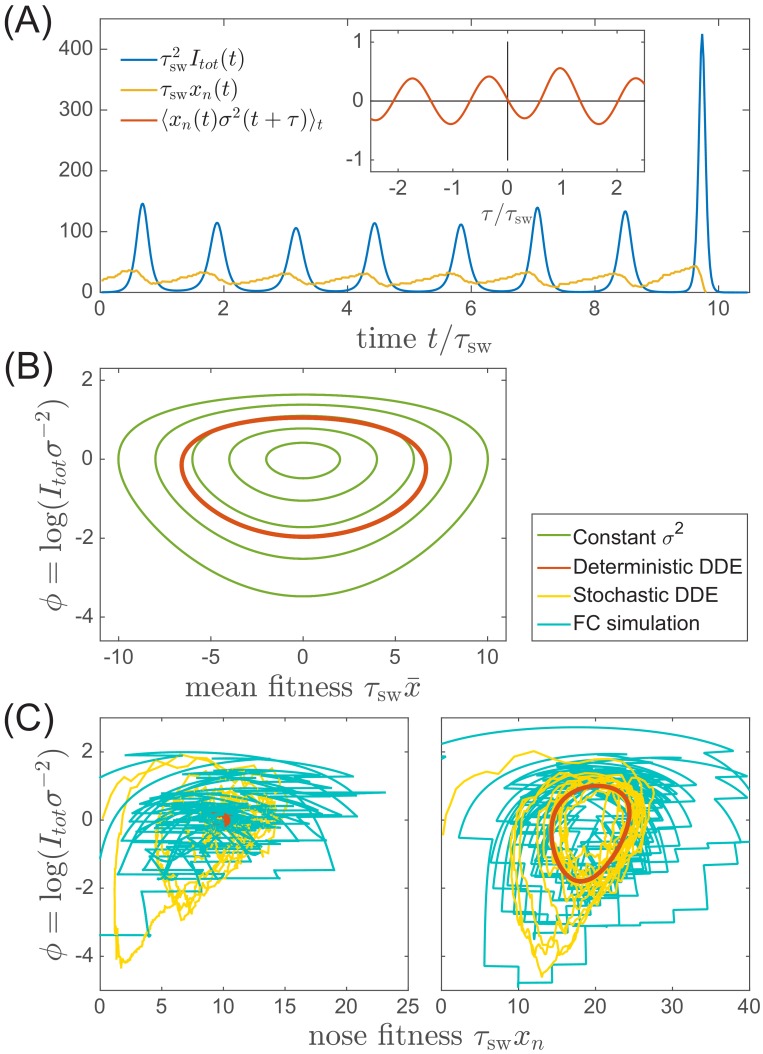
Oscillations in antigenically evolving populations.(A) An example of the stochastic limit cycle trajectory from the fitness-class simulation. Note the rapid rise and fall of infection prevalence (blue), which causes a drop in nose fitness (yellow) which subsequently recovers (approximately linearly) during the remainder of the cycle. Fluctuations in It⁢o⁢t⁢(t) and xn⁢(t) from cycle to cycle are caused by the stochasticity of xn, that is antigenic evolution in pioneer strains. A particularly large fluctuation about τsw prior to the end, caused a large spike in prevalence, followed by the collapse of xn below zero and complete extinction. Inset (red) shows the cross-correlation between xn and σ2 which peaks with the delay τ=τsw (additional peaks reflect the oscillatory nature of the state and are displaced by integer multiples of mean period). (B) A family of limit cycles in the infection prevalence/mean fitness plane as described by Equation (11) with fixed variance. The variation of σ governed by the Equations 11 and 12 (in the deterministic limit) reduces the family to a single limit cycle (red); (C) Trajectories in the infection prevalence/nose fitness generated by the stochastic DD system in the regime above (right panel) and below (left panel) the oscillatory instability of the deterministic DD system.